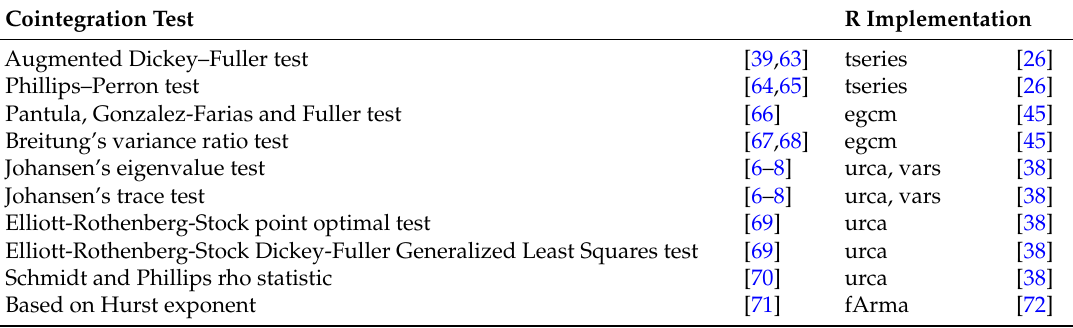
Table 5. Set of cointegration tests applied in this study. Note that critical values for cointegration testing and corresponding p -values for all deployed tests are taken from egcm; see